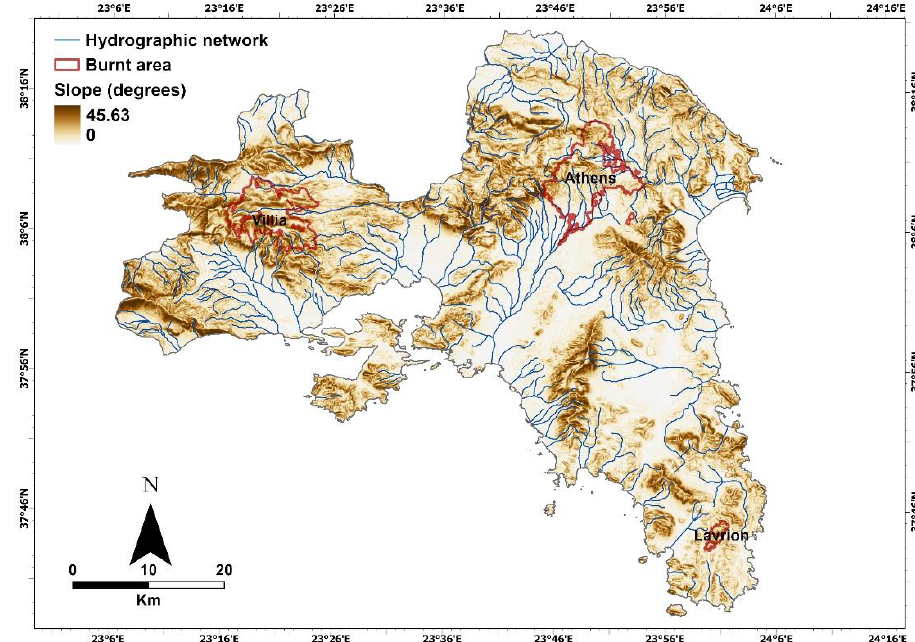
Figure 4. Morphological slopes of the fire-affected areas in Attica.